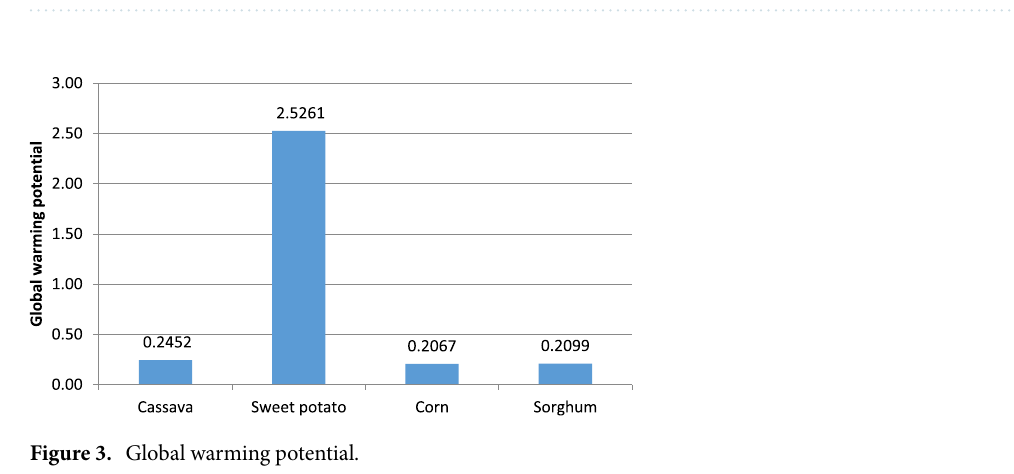
Table 5. Net present value, internal rate of return, and discounted payback period.